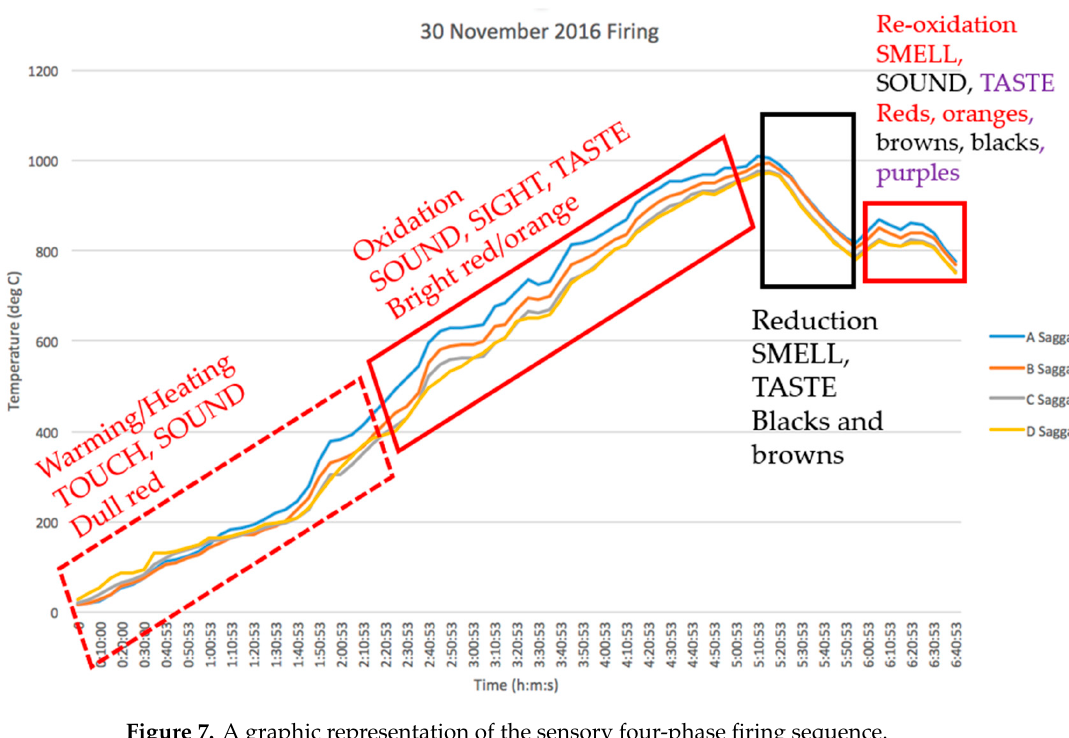
Figure 7. A graphic representation of the sensory four-phase firing sequence. Arts 2019 , 8 , x FOR PEER REVIEW